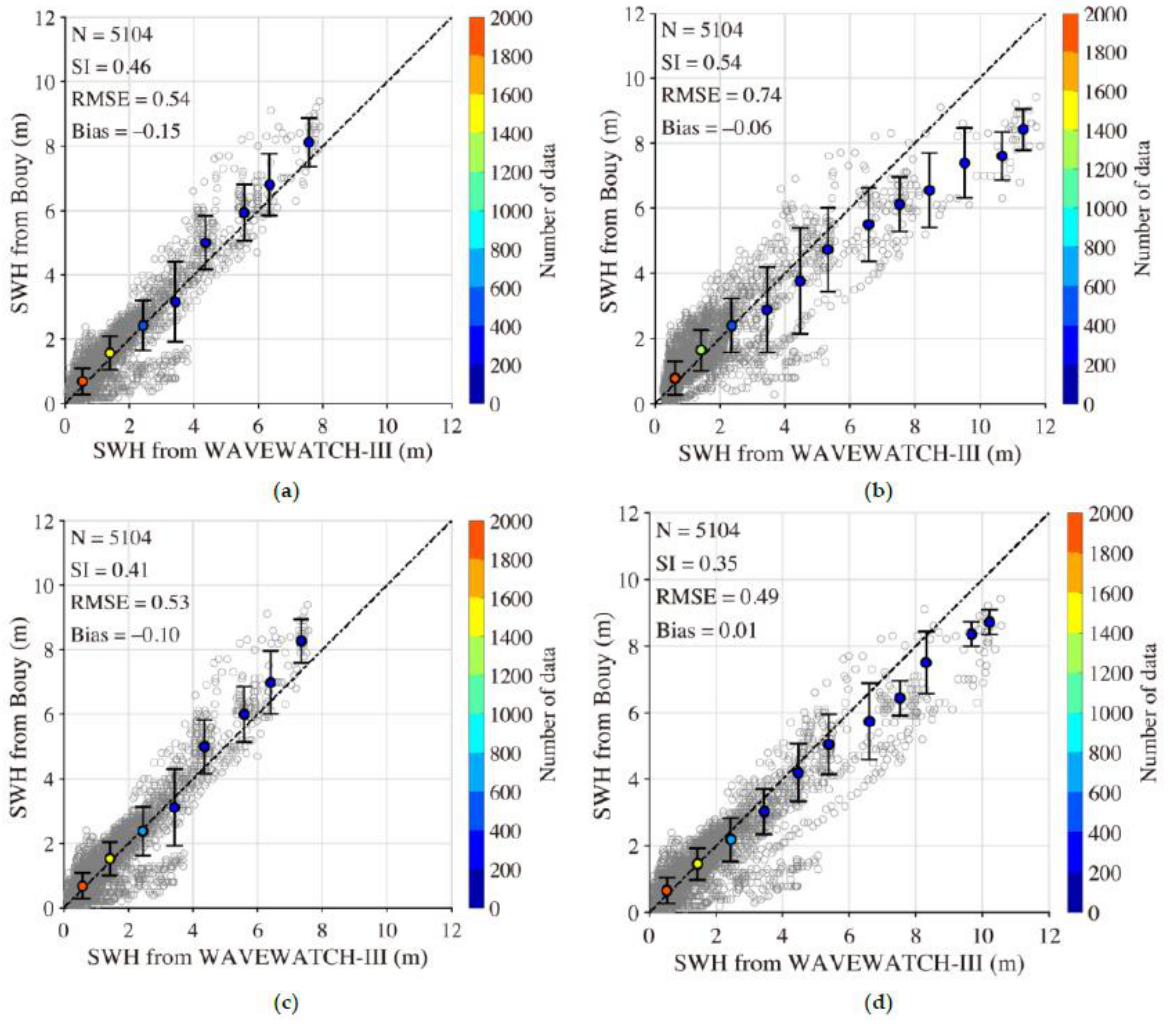
Figure 10. The statistical analysis of WW3-simulated H s compared with the measurements from all available buoys using parameterizations adapted from in [2] ( a ), [57] ( b ), [59] ( c ), and this study ( d ), in which the error bars represent the standard deviations for a 1 m bin of H s up to about 10